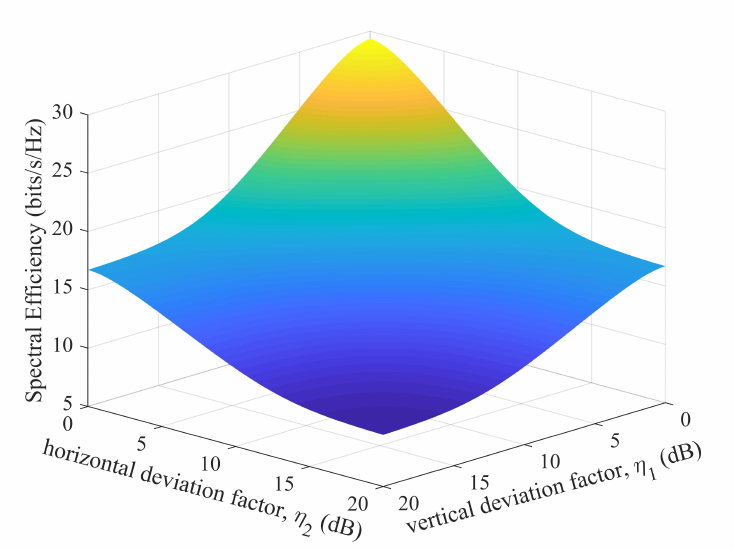
Figure 7. Spectral efficiency for different η 1 and η 2 with ¯ γ = 10 dB when H = H LOS